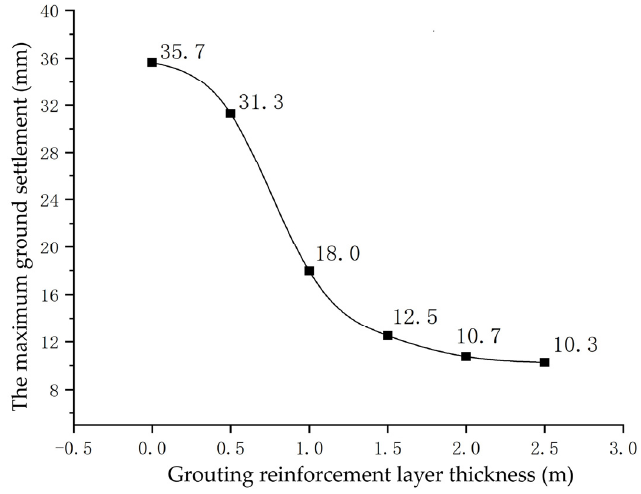
Figure 14. Relationship between the maximum ground settlement and the grouting reinforcement layer thickness.